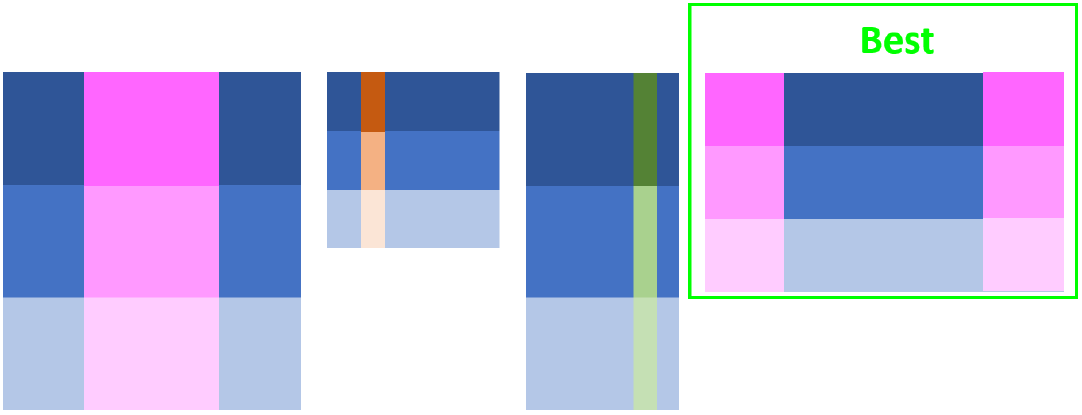
Figure 10. An example of the selection of the best individual of the population.